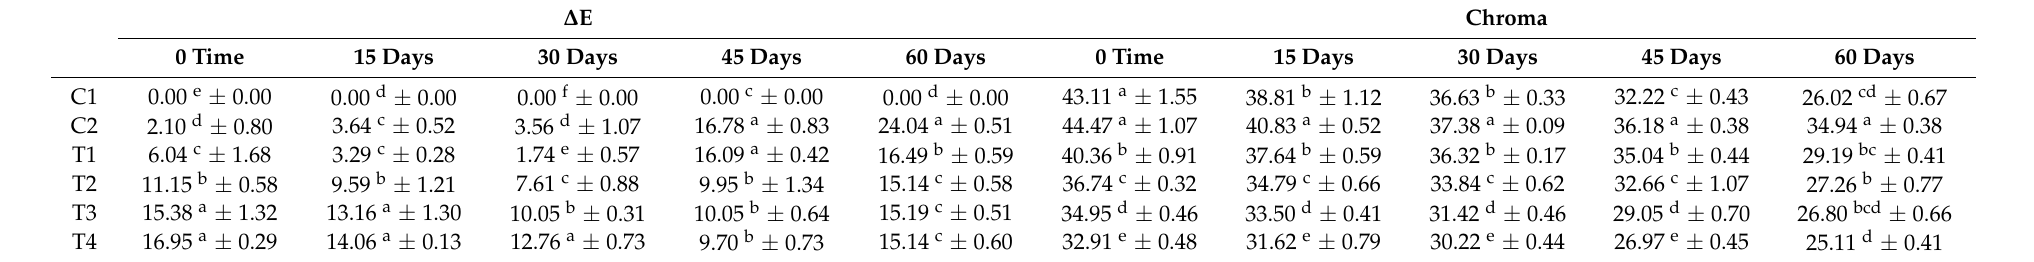
Means with the same letter in columns are not statistically significant ( p ≤ 0.05), while means sharing a different letter in columns of the table are significantly statistical ( p ≤ 0.05). C1, mayonnaise with no antioxidants; C2, mayonnaise treated by 0.02% BHT; T1, T2, T3, T4: mayonnaise treated by 0.125, 0.25, 0.5, and 0.75% ethanolic Rosa canina extract, respectively. Table 14. Changes in ∆ E and chroma values of mayonnaise samples enriched with RCFE during storage. ∆ E